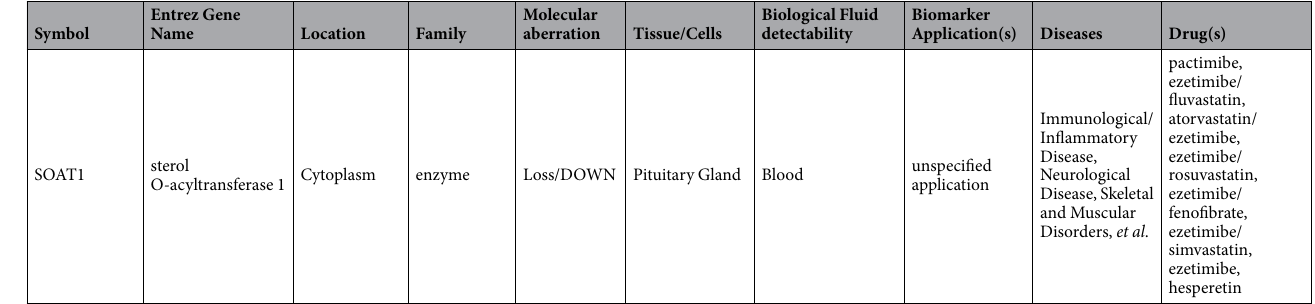
Table 4. The most promising candidate CNV-driven genes and their utility as potential biomarkers/targets for SALS. The table lists CNV-driven genes showing the same expressional tendencies between DNA copy number and mRNA expression in SALS subgroups as potential candidate biomarkers and therapeutic targets for ALS. Target and biomarker assessment was performed by using dedicated tools in IPA and MetaCore. UP: upregulation. DOWN: